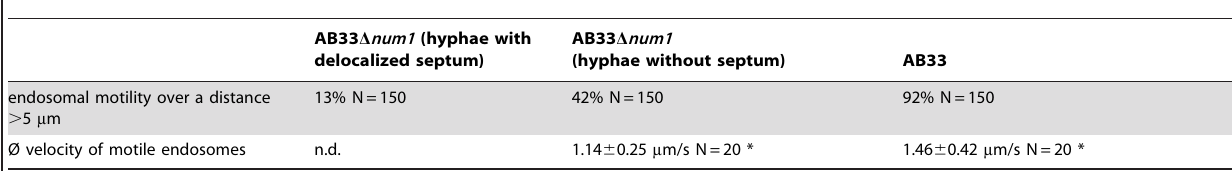
Table 2. Reduced endosomal motility in num1 -deletion strains.